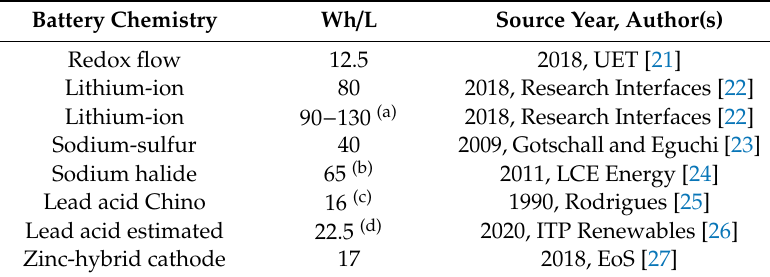
Table 2. System volume by battery technology.